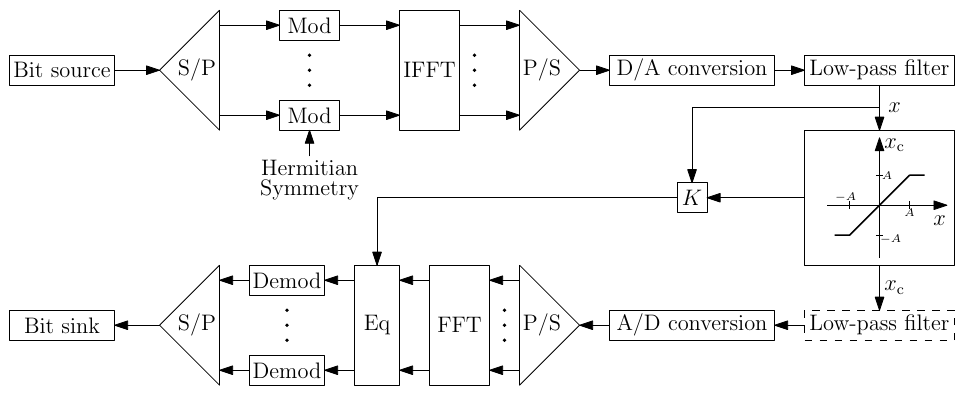
Figure 1. System model that is investigated in this